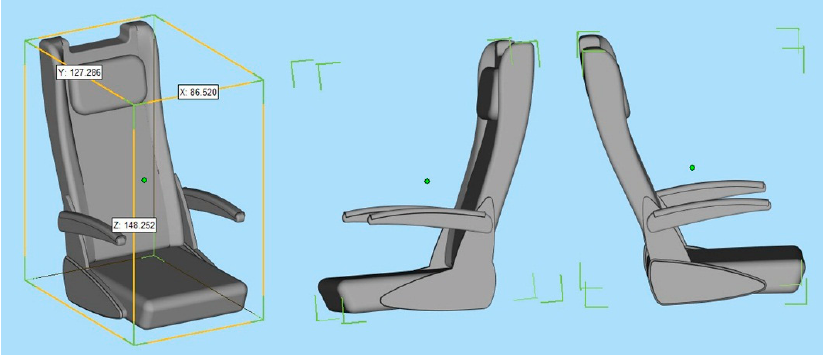
Figure 15. The 3-D printed drawing of the seat form sample 3.